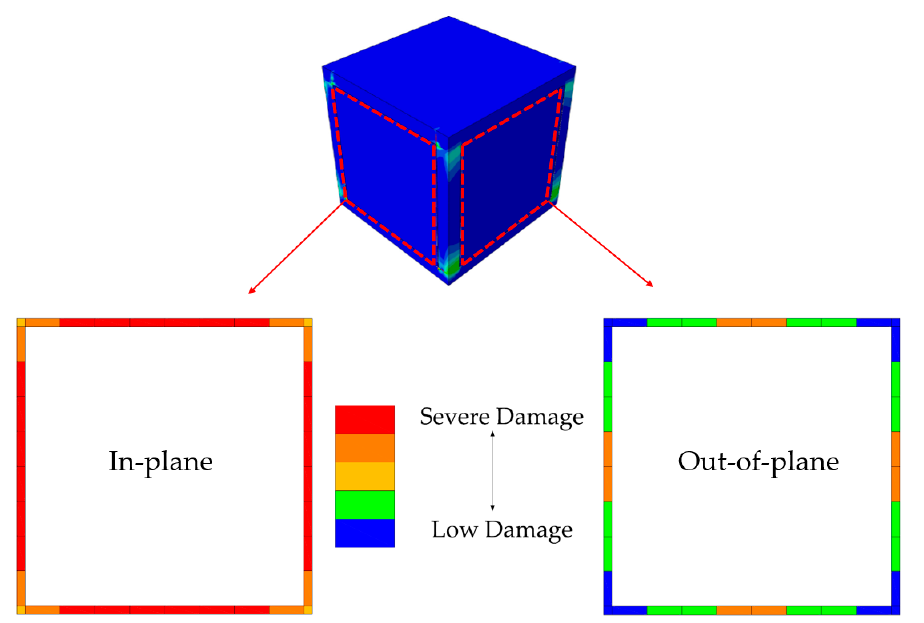
Figure 21. Mortar bonding failures for the TM Building.